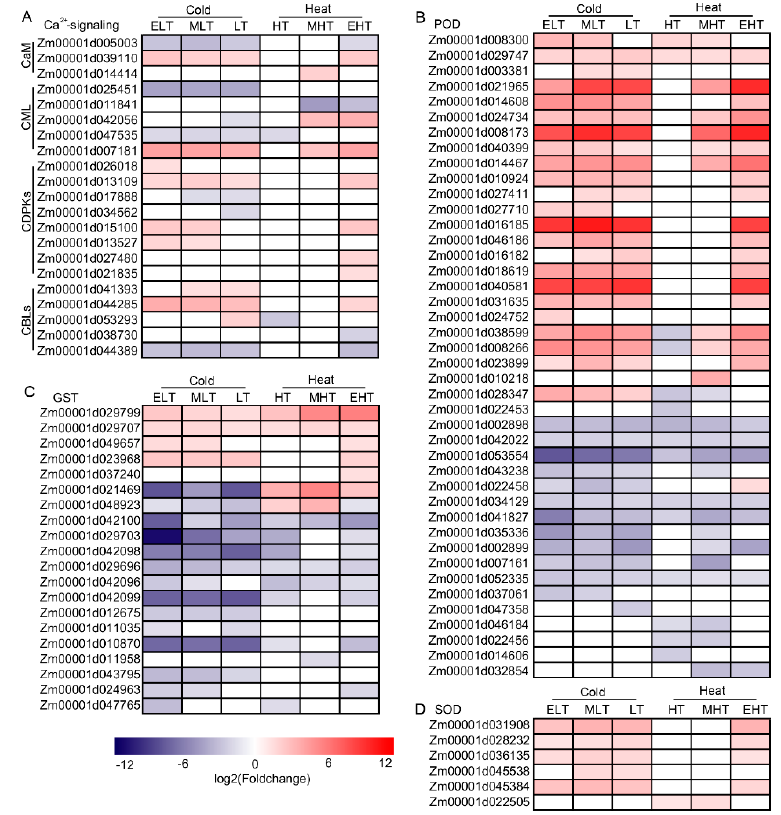
Figure 3. Heatmap of the differentially expressed genes (DEGs) involved in Ca 2+ signaling and ROS-scavenging in response to temperature stress. ( A ) The heatmap of DEGs involved in Ca 2+ signaling. ( B ) The heatmap of DEGs encoded GST. ( C ) The heatmap of DEGs encoded POD. ( D ) The heatmap of DEGs encoded SOD. CaM, calmodulin, CML, CaM-like proteins; CDPKs, Ca 2+ -dependent protein kinases; CBLs, calcineurin B-like proteins; POD, peroxidase; GST, glutathione S-transferase; superoxide dismutase. ELT, extreme low temperature, 4 °C; MLT, medium low temperature, 10 °C; LT, low temperature, 16 °C; NT, normal temperature, 25 °C; HT, high temperature, 37 °C; MHT, medium high temperature, 42 °C; and EHT, extreme high temperature, 48 °C.